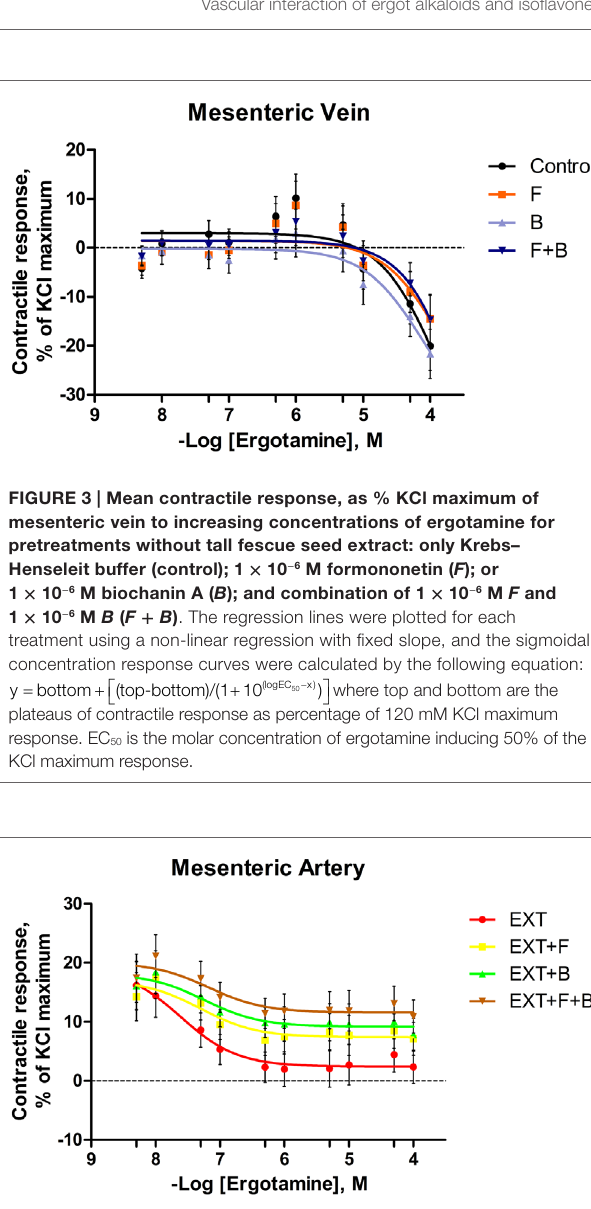
FigUre 4 | Mean contractile response, as % Kcl maximum of mesenteric artery to increasing concentrations of ergotamine for pretreatments with tall fescue seed extract: 1 × 10 − 6 M ergovaline- containing tall fescue seed extract (eXT); combinations